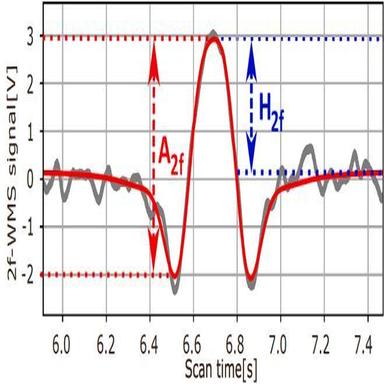
Illustrative estimation of the 2f-WMS peak height H2f and corresponding amplitude A2f (including offset correction) for a sample dataset relevant to Scenario B, see below for more details.